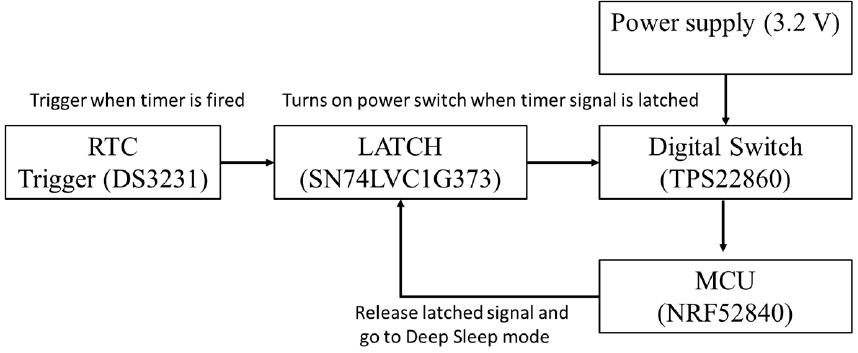
Figure 2. Functional block diagram of power management circuit. Since RTC is an active low device the generated signal on trigger was then inverted by NOT-gate and connected to the latch (SN74LVC1G373 from Texas Instruments, Dallas, TX, USA). The digital switch (TPS22860 from Texas Instruments, Dallas, TX, USA) controlled by the latch signal is to provide the regulated voltage from MCP1725 by microchip delivered to MCU. All the devices considered in the design of the power management circuit have low power consumption. Overall power consumption during sleep mode by each component is listed in Table 1. Note that the electrical resistance sensing circuit is supplied with constant power to avoid polarization time in S-UHPC. The power consumption in the electrical resistant sensing circuit was estimated at 1.6 µ A (i.e., supplied power of 3.2 V/total resistance by the S-UHPC and R1). The total power consumption in the Deep Sleep mode is 242.6 µ A and in the activation mode is 10.2 mA. Given a 10,000 mAh battery and ten sensing events with 60 s of operation, the developed WSS can last 3.68 years, consuming an average of 310 µ A. Table 1. Power consumption in Deep Sleep